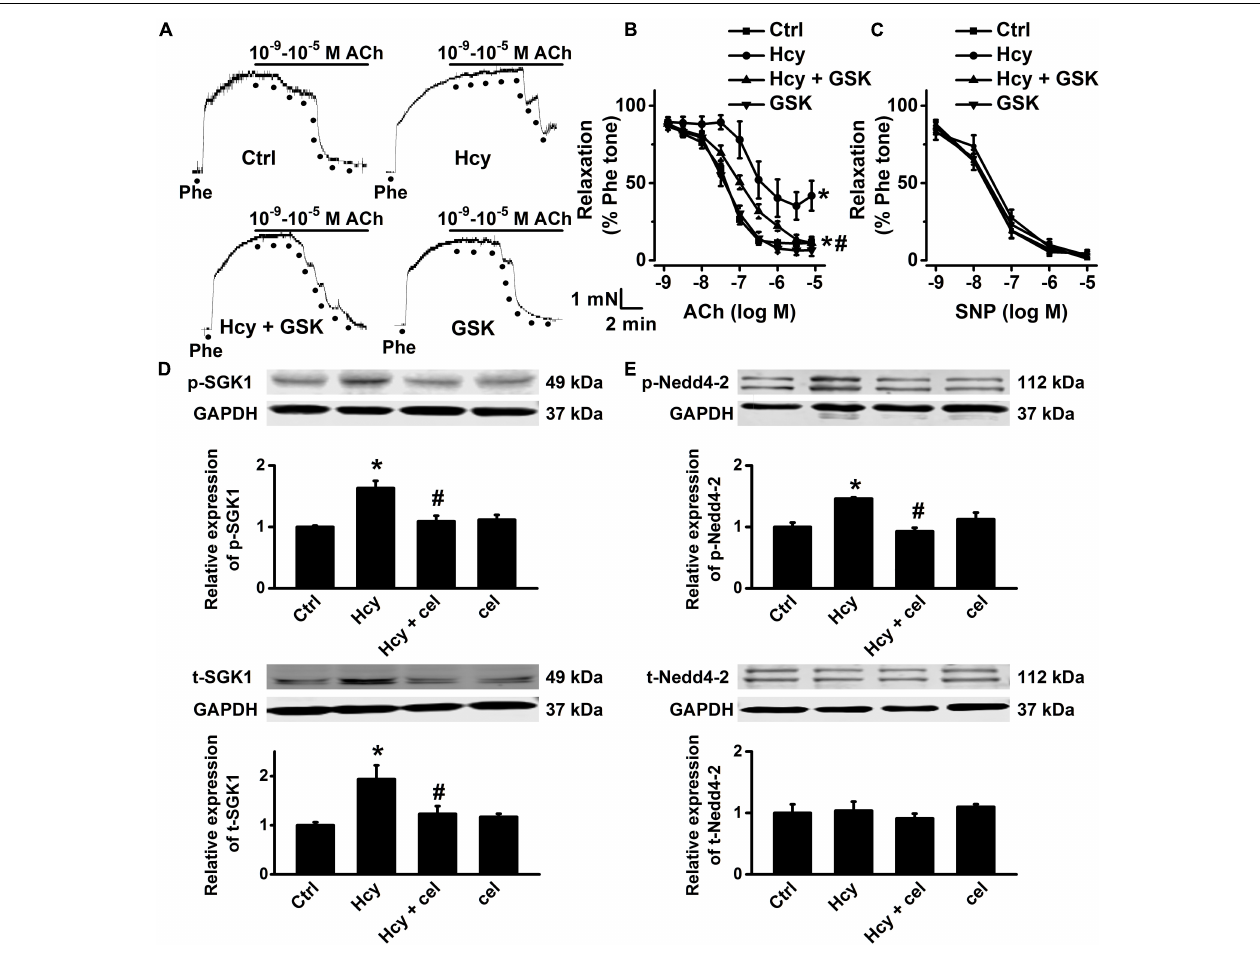
FIGURE 7 | Celecoxib ameliorated Hcy-induced impairment of EDR by inhibition of SGK1/Nedd4-2 signaling. (A) Representative traces obtained from wire myograph assays under each indicated condition and (B) summarized data of ACh-induced relaxation of aorta either under control condition or, respectively, treated with 100 µ M Hcy, 100 µ M Hcy plus 10 µ M GSK650394 (GSK), or 10 µ M GSK650394 alone for 6 h. The first dot indicates the application of 10 − 9 M ACh to the 1 µ M Phe precontracted arterial rings, whereas the following dots indicate ACh concentrations ranged from 10 − 8 . 5 to 10 − 5 M. Data are means ± SEM of six mice. * P < 0.05 vs. ctrl; # P < 0.05 vs. Hcy. (C) Summary of artery relaxation induced by 10 − 9 to 10 − 5 M SNP in aorta from the four individual experiments. (D,E) Representative Western blots demonstrating the expression of total SGK1 (t-SGK1), phosphorylated SGK1 (p-SGK1), total Nedd4-2 (t-Nedd4-2) and phosphorylated Nedd4-2 (p-Nedd4-2) under control condition or, respectively, treated with 100 µ M Hcy, 100 µ M Hcy plus 3 µ M celecoxib, or 3 µ M celecoxib alone for 6 h. Summary plots of Western blots, showing the summarized expression levels of t-SGK1, p-SGK1, t-Nedd4-2, and p-Nedd4-2 under each indicated condition. Data are means ± SEM of six experiments in each group. * P < 0.05 vs. ctrl; # P < 0.05 vs.